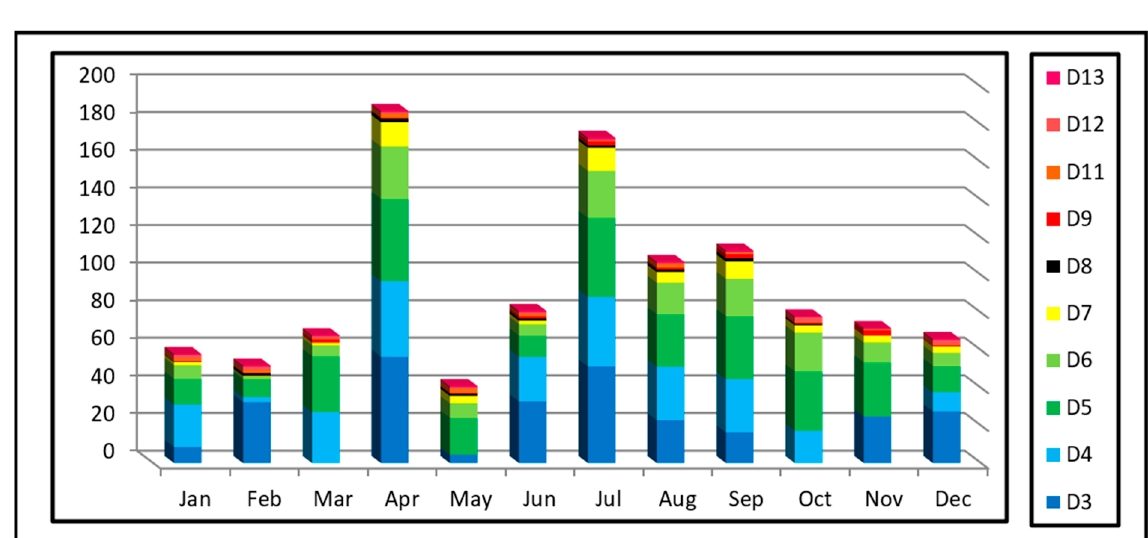
Figure 11. Reused drainage water in agriculture area (MCM).